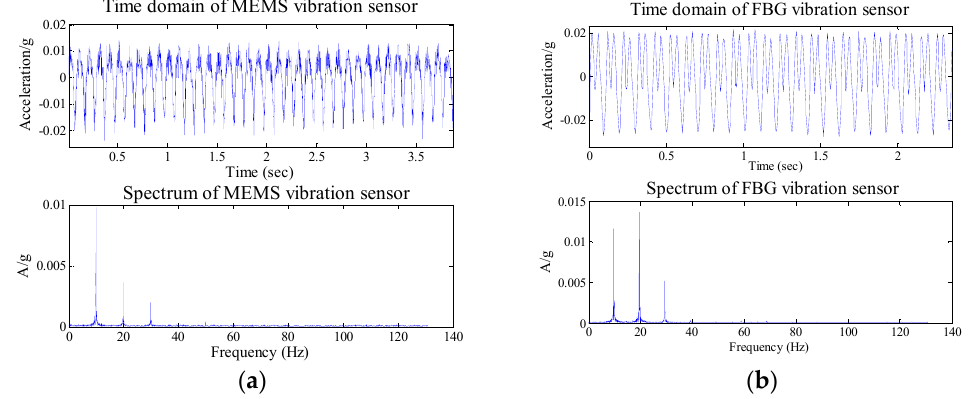
Figure 14. Time domain and spectrum map of the two sensors with s frequency of 10 Hz and current of 0.8 A. ( a ) Time domain and spectrum map of the MEMS vibration senor; ( b ) Time domain and spectrum map of the FBG micro-vibration senor.